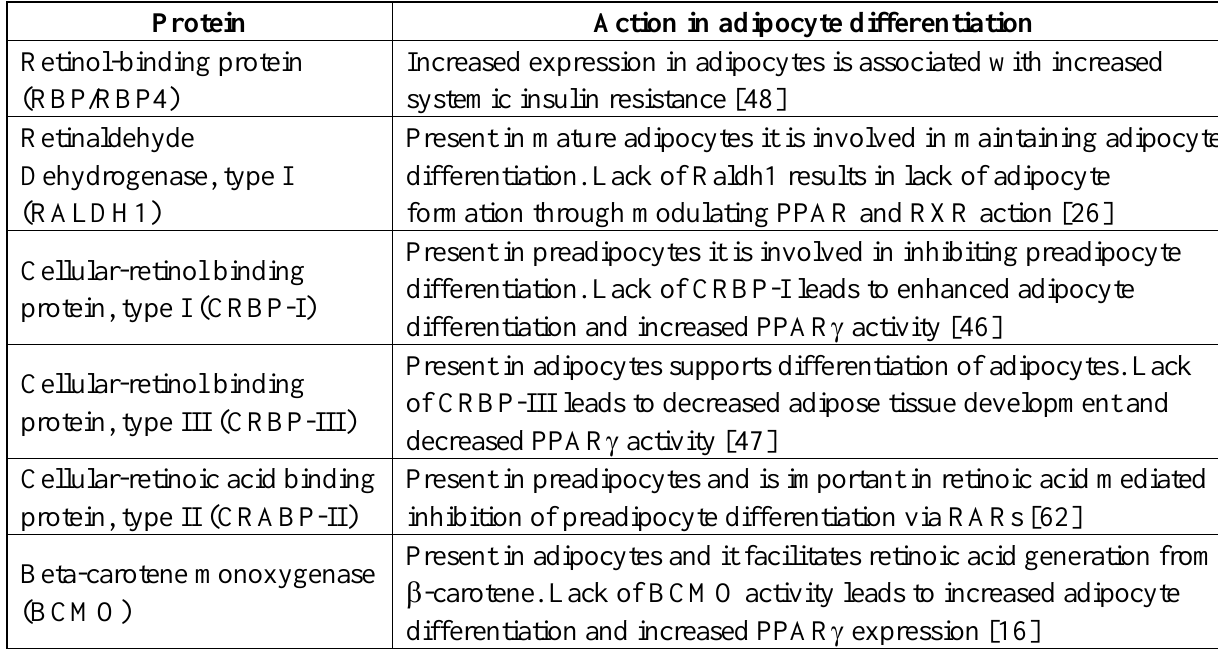
Table 1. Retinoid action in adipocyte differentiation (details see